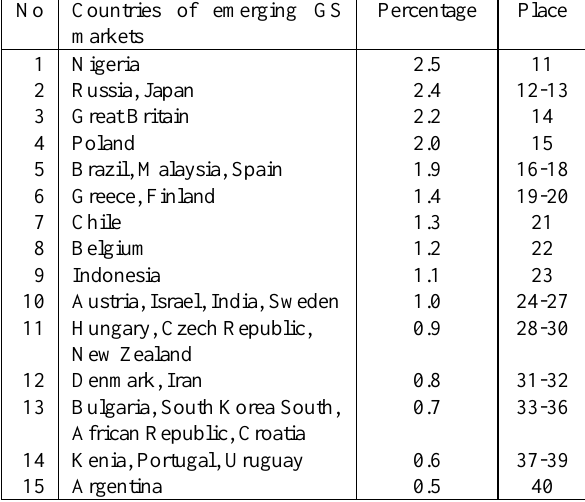
Table 5. Countries of emerging GS